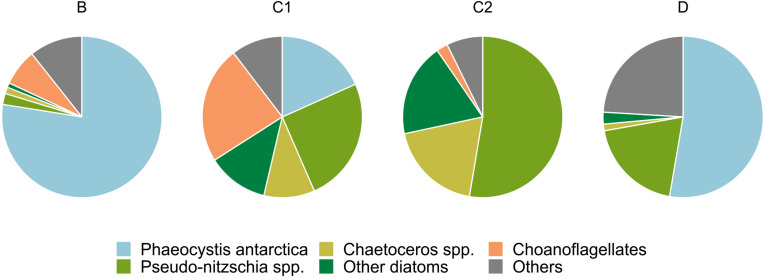
Compositional pie charts of plankton net samples used to generate phytodetritus.